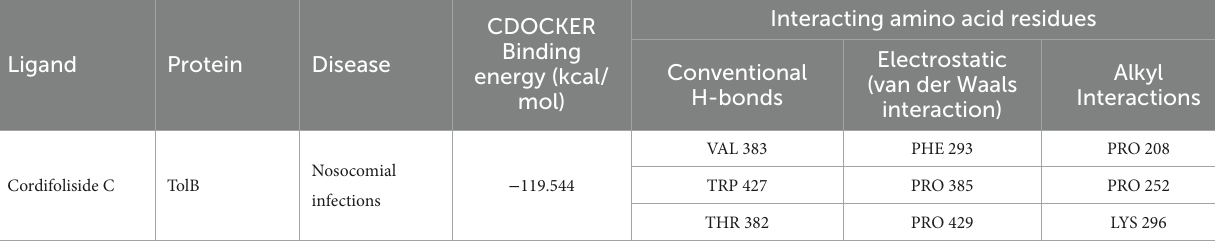
TABLE 7 Different interactions between binding site residues of Cordifoliside C and TolB